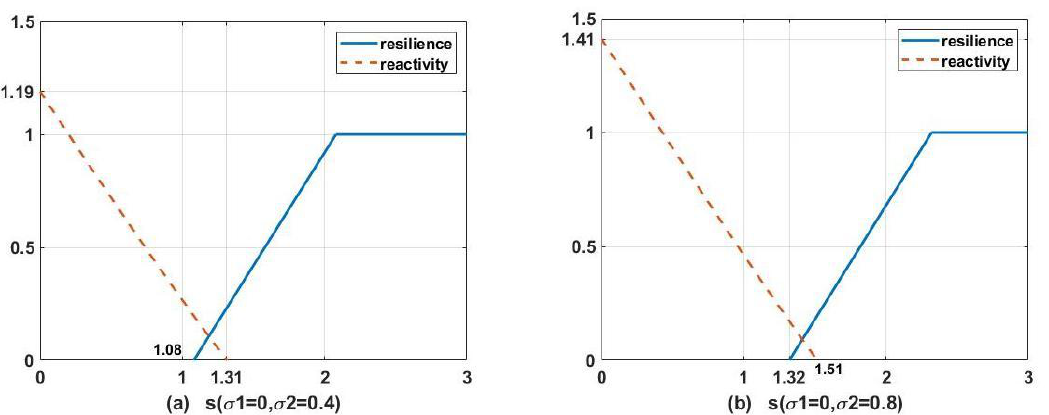
Figure 3. Resilience and reactivity of the system (7) when the predator is disturbed (mean square